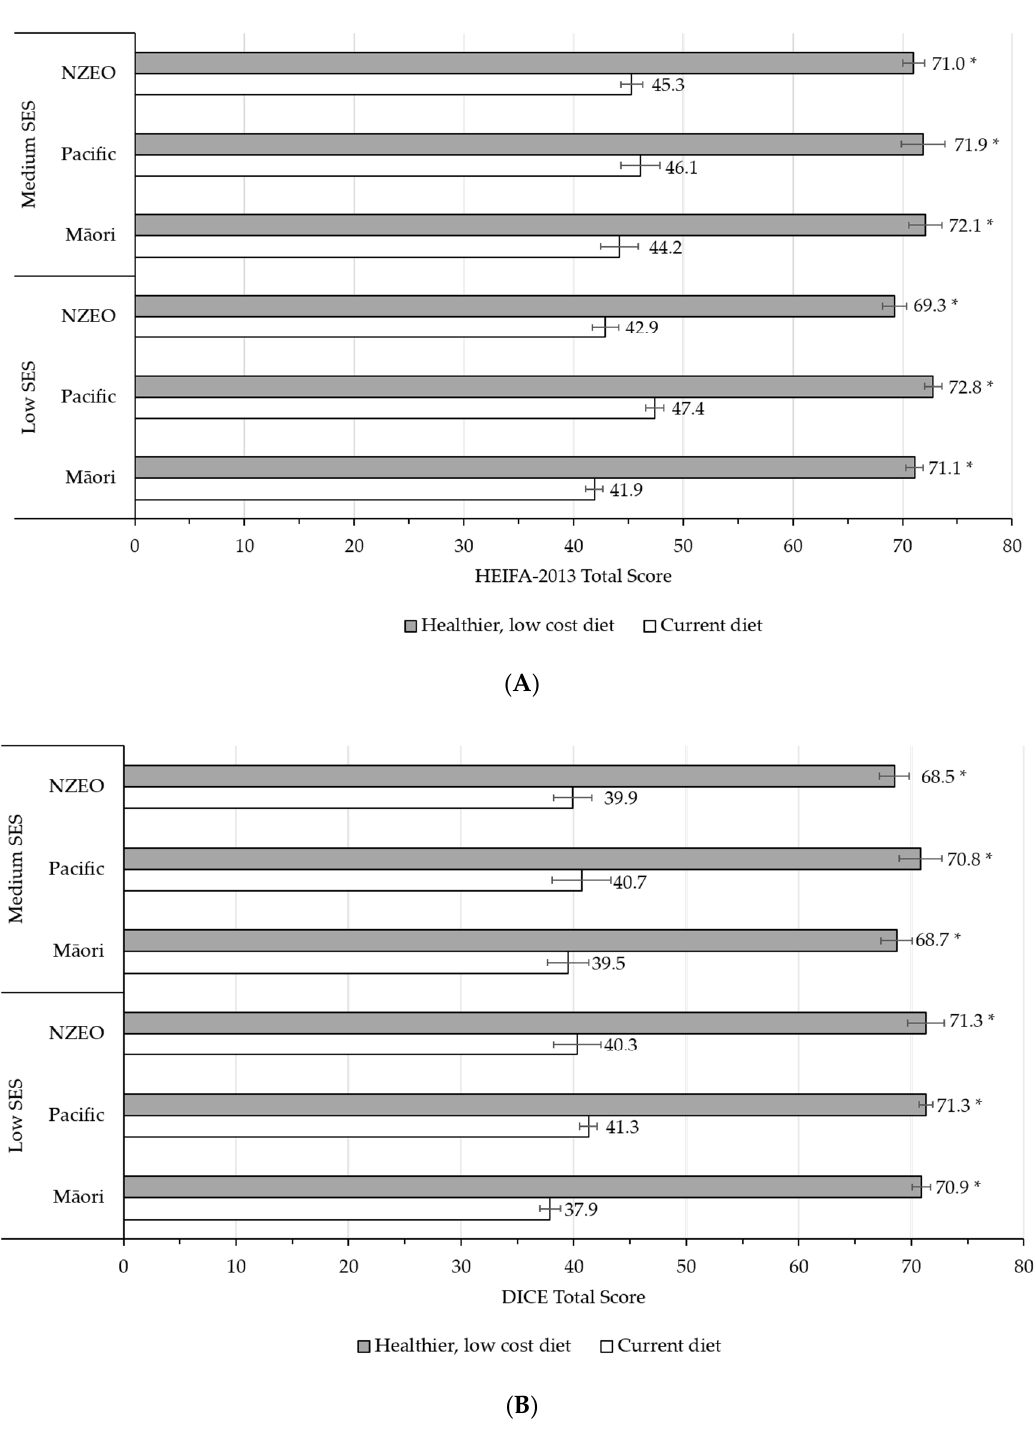
Figure 3. Diet quality of the current and healthier, low-cost diets, using validated diet quality indices. ( A ) HEIFA-2013 (Healthy Eating Index for Australian Adults) [37] assessment of the adult current and healthier, low-cost diets for Māori, Pacific, and NZEO low and medium SES households ( B ) DICE (Dietary Index for Child’s Eating) [38] assessment of the children’s current and healthier, low-cost diets for Māori, Pacific, and NZEO low and medium SES households. Statistical significance is denoted by * ( p < 0.001); comparisons are between current and healthy diets within each group. SES, socioeconomic status.